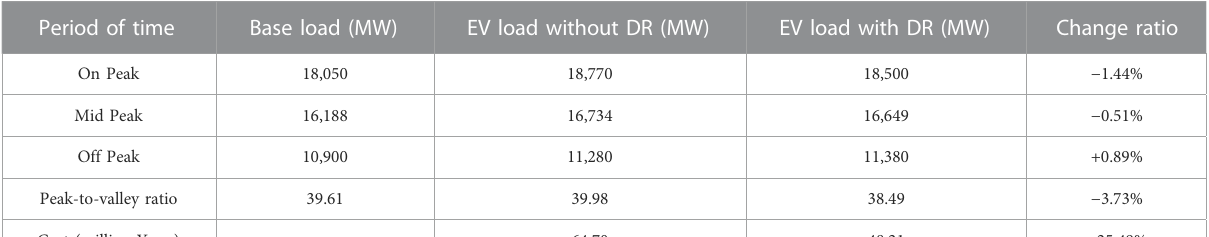
TABLE 2 simulation results.